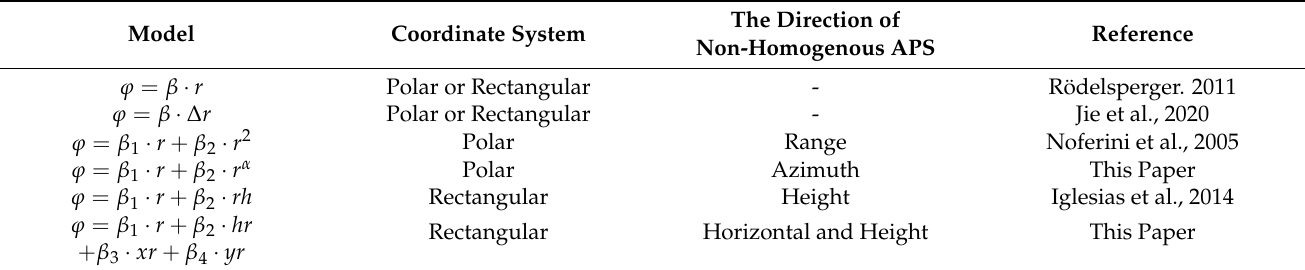
Table 5. The comparison of existing and proposed